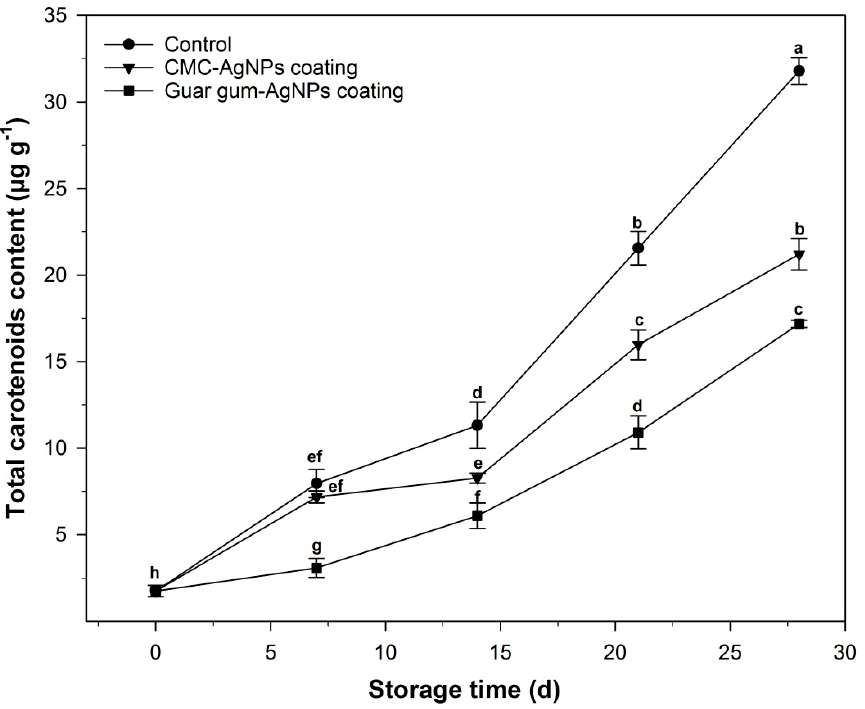
Figure 12. Effect of CMC-AgNP and guar gum-AgNP coatings on total carotenoid content of “Seddik” mango fruit stored at 13 °C for 4 weeks. Vertical bars represent the SE of means. Means with the same letter are not significantly different according to Duncan’s multiple range test ( α ≤ 0.05).